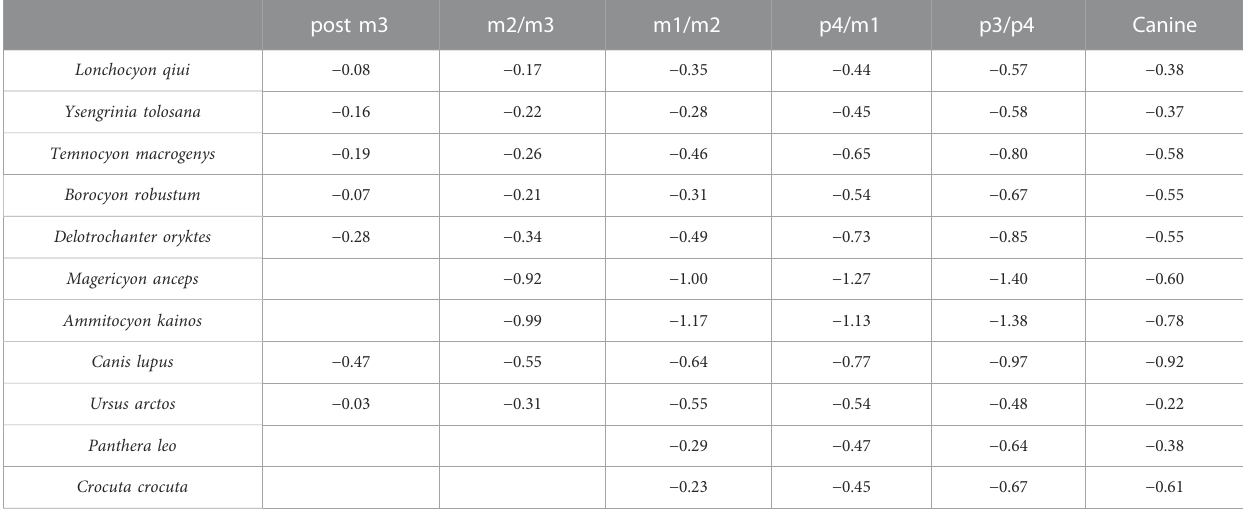
TABLE 3 Dorsoventral mandibular force (logZx/L) values of L. qiui and compared carnivorans along the mandible.